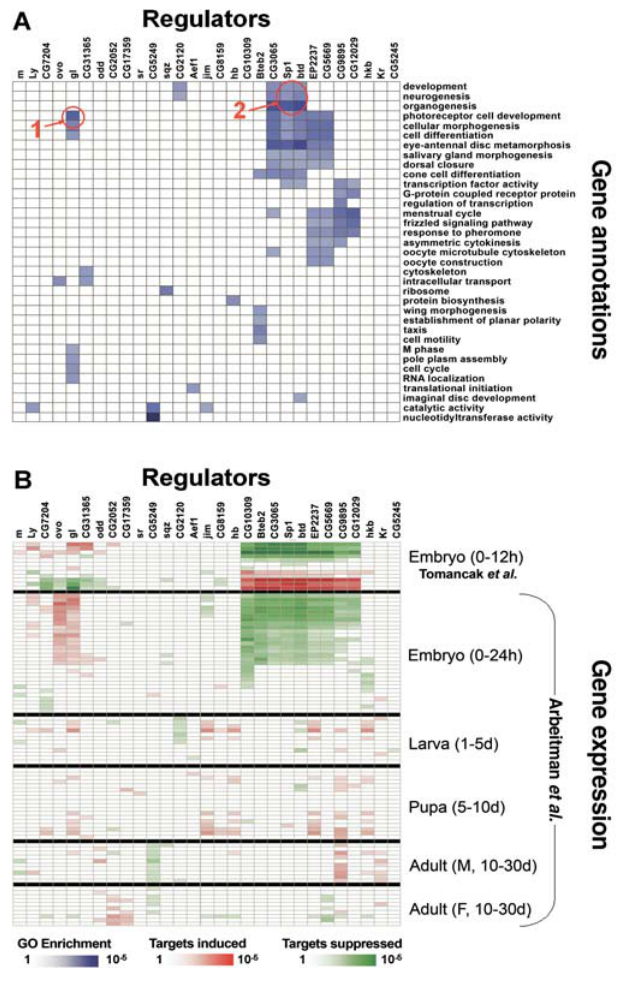
Figure 6. Inferring the Function and Activity of Zinc Finger Transcription Factors in D. melanogaster (A) Similar gene annotation enrichment among the putative target sets of 29 transcription factors in D. melanogaster . Blue cells correspond to significant overabundance of a GO term (row) among the predicted targets of a protein (column), using a hyper-geometric test. The binding sites of most factors show enrichment in at least one GO term. For some of the regulators, the enriched GO terms match prior biological knowledge. For example, the putative targets of Glass (gl) were found to be enriched with terms related to photoreceptor cell development (red circle 1). Similarly, the putative targets of Buttonhead (btd) and Sp1 were enriched with developmental terms such as neurogenesis, development, and organogenesis (red circle 2). Closely related GO annotations are not shown; see Figure S4 for full results. (B) Deducing the activity of the 29 transcription factors using gene expression patterns. Expression data from early (0–12 h) embryogenesis [20] and data from the entire Drosophila life cycle [21] are used to test whether the putative direct targets of a regulator are expressed differently than the rest of the genes in a given experiment. Red cells correspond to significant enrichment of overexpressed targets using a Kolmogorov-Smirnov test, while green cells correspond to enrichment of underexpressed targets. For most of the regulators the analysis resulted in at least one significant embryogenesis experiment, suggesting an active role in early developmental stages (above). Similar results were obtained using the full life cycle gene expression data (below). DOI: analyses show that a residue may have different nucleotide preferences depending on its context. For some amino acids, the qualitative preferences remain the same across various positions, while the quantitative preferences vary (e.g.,